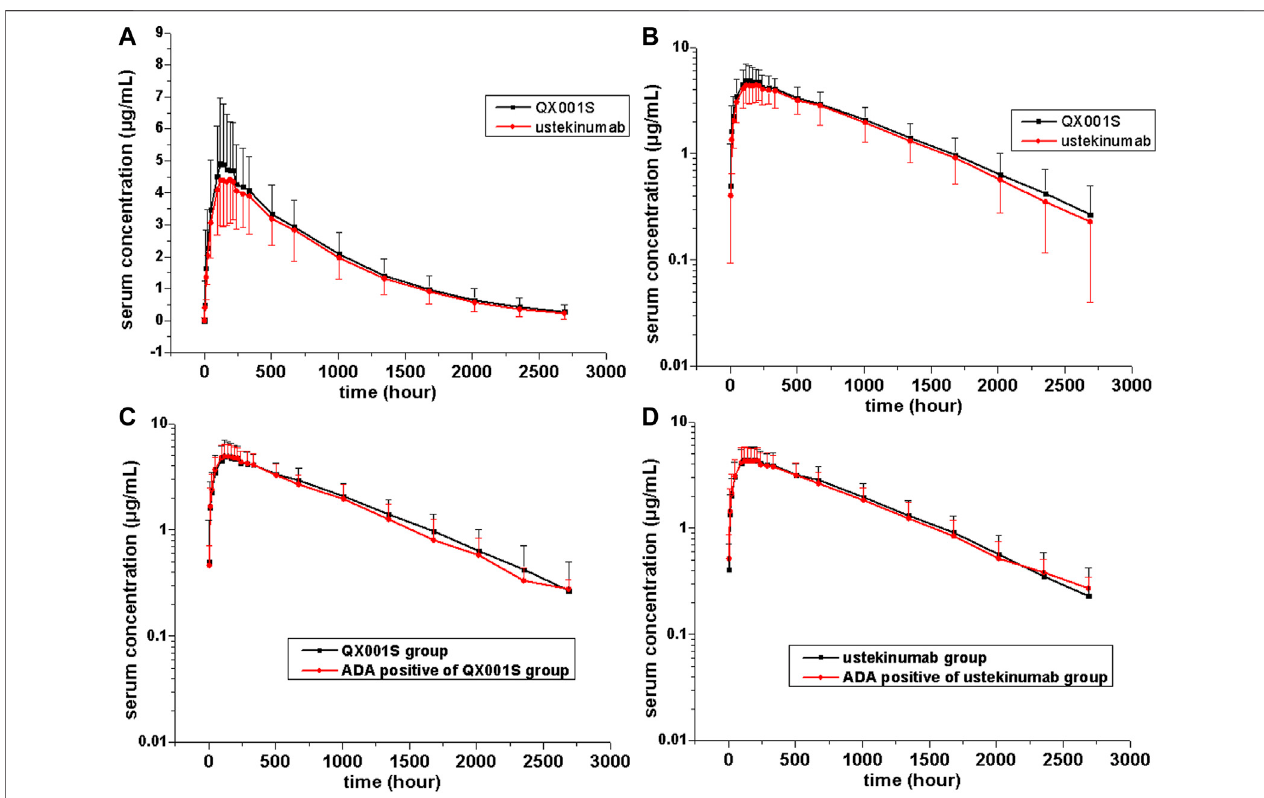
FIGURE 2 | Serum drug concentration-time pro fi les for ustekinumab and its biosimilar. Mean ± standard deviation values (A) ; log10 mean ± standard deviation values (B) ; Mean ± standard deviation values of ADA-positive and total individuals in the QX001S (C) and ustekinumab (D) groups.